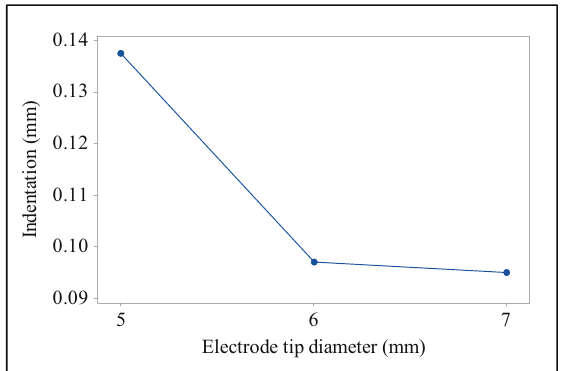
Figure 9: Effect of electrode tip diameter on electrode